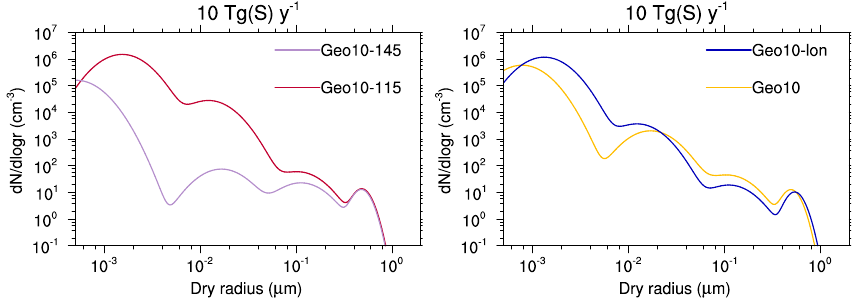
Figure 4. Aerosol number size distribution of particles in a height of 54hPa at the Equator for injection rates of 10Tg ( S ) yr − 1 . (Left) Geo10 averaged over a 10 ◦ wide area upwind (Geo10-145) and downwind (Geo10-115) of the injection area (see also Fig. 3). (Right) Zonal average of Geo10 and